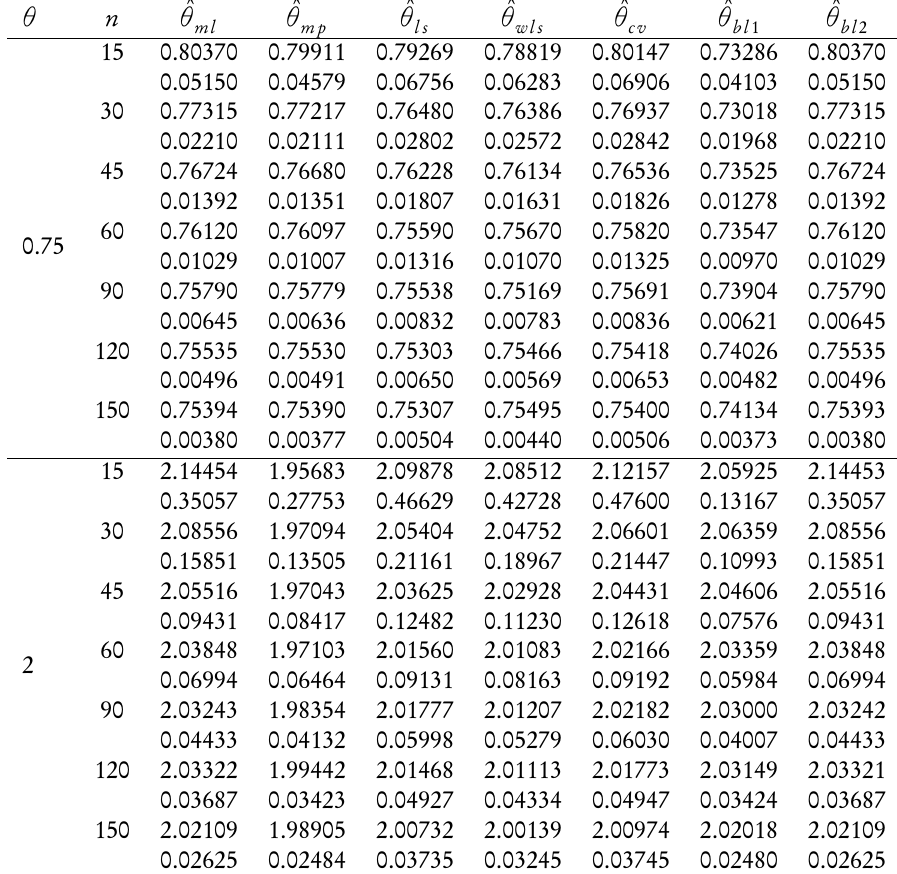
Average estimate and corresponding mean square error (second